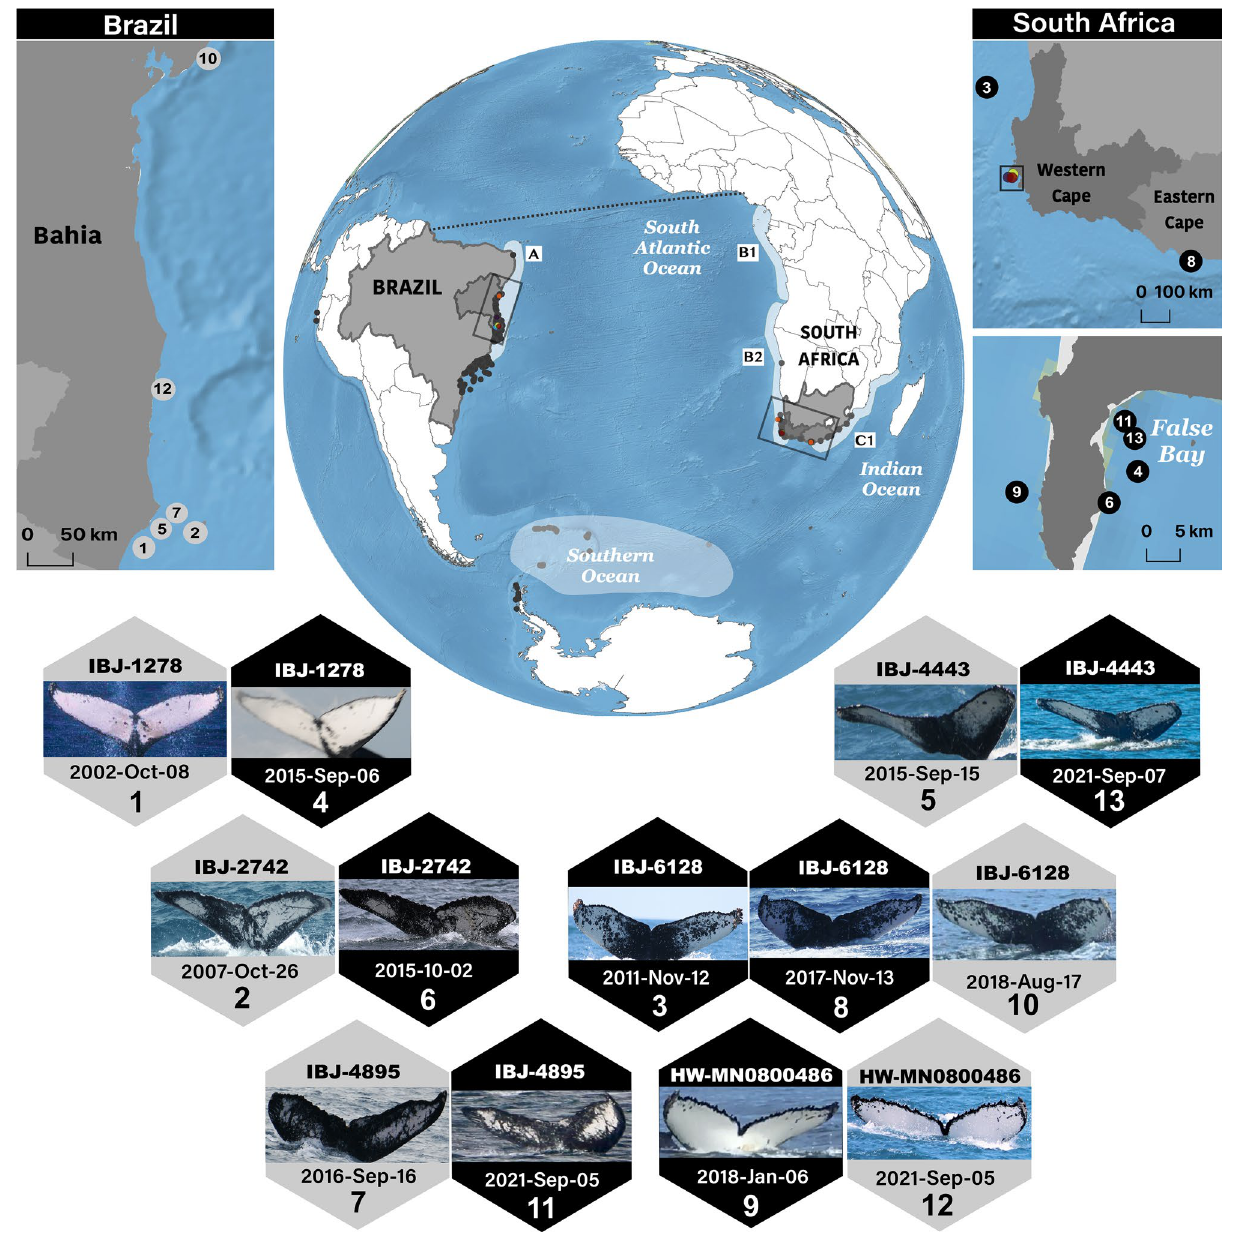
Figure 1. Maps of sighting locations and fluke images of six Southern Hemisphere humpback whales ( Megaptera novaeangliae ) photographed across the South Atlantic Ocean and Southwestern Indian Ocean (with the indication of the respective Breeding Stock or substock, A, B1, B2, and C1). The top left inset map shows whale sightings along the Atlantic coast of Brazil and the top right inset maps depicts sightings in the Western and Eastern Capes of South Africa (top) and zoomed in view of sightings in and outside of False Bay. Fluke images of each identified whale in the hexagons are numbered with sightings in Brazil colored gray and in South Africa colored black. The white oval in the Southern Ocean shows the Atlantic sector (Area III) of the Antarctica feeding grounds visited by humpback whales from Africa. Maps were created in QGIS version 3.28.3 (www. qgis.